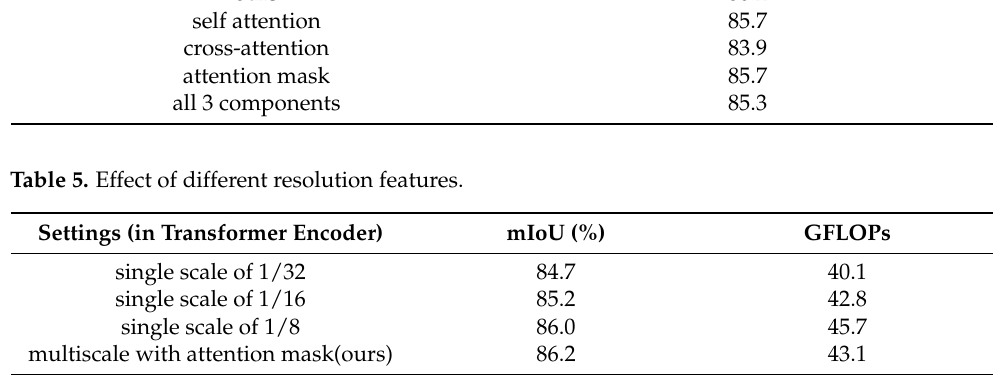
Table 4. Effect of the component in the transformer decoder.